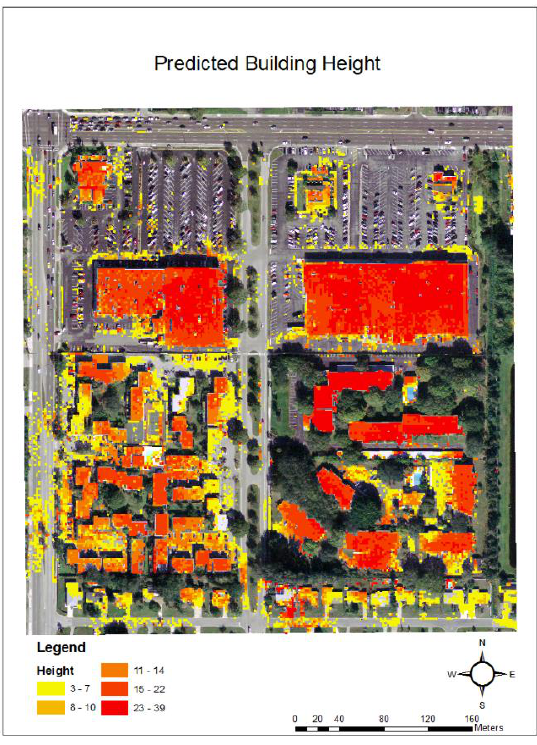
Figure 8. The Predicted Building Height